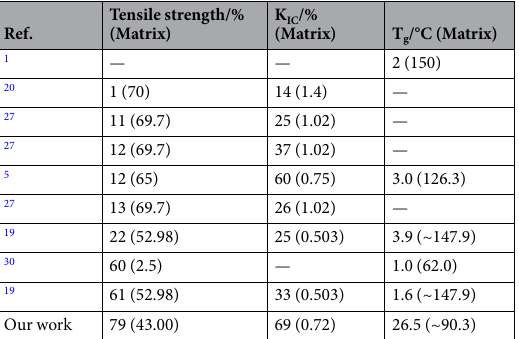
Table 2. Comparison of increments in the T g , tensile strength, K IC among various commercial DGEBA composites containing 0.5 wt.% GO